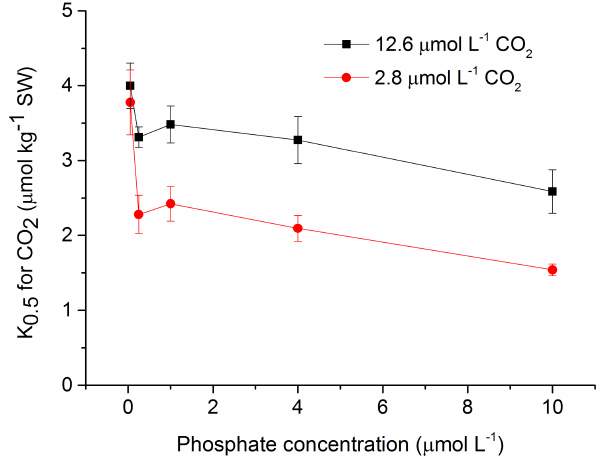
Figure 5. Half saturation constant ( K 0 . 5 ) for CO 2 in S. costa- tum grown at various phosphate concentrations after 12.6 and 2.8µmol CO 2 treatments. The error bars indicate the standard devi- ations ( n = 3).